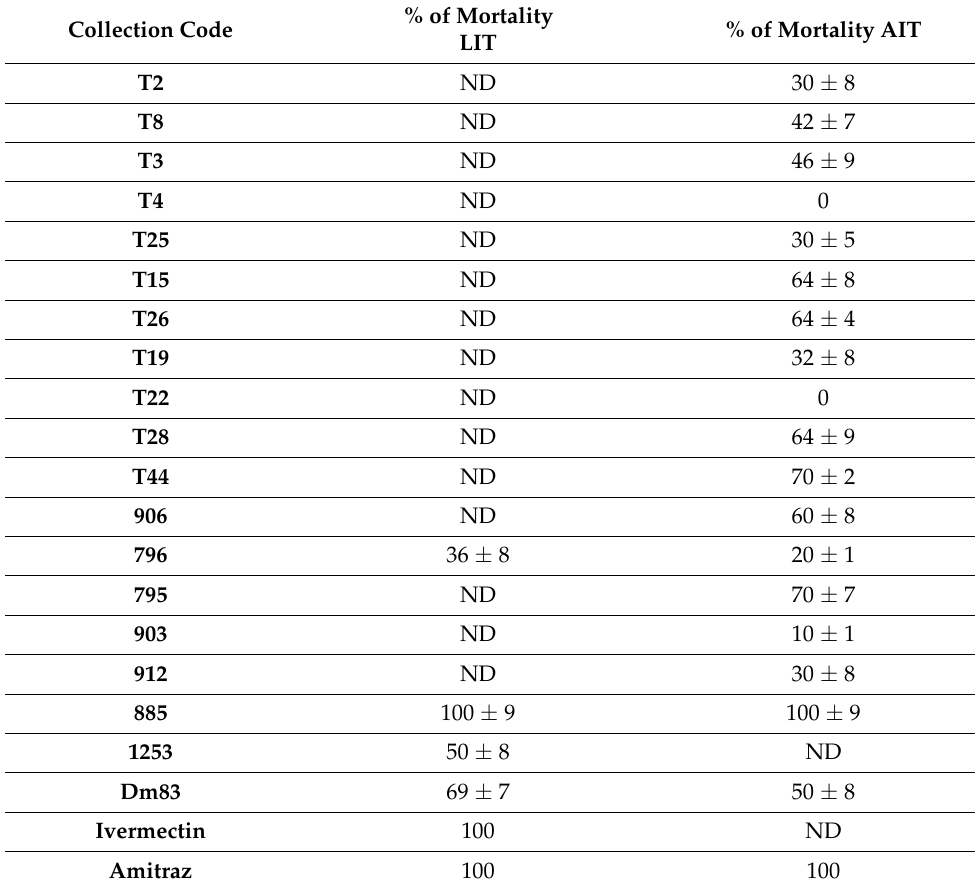
Table 4. Toxicity effect of extracts (1 mg/mL) and compounds in the LIT (1.0 mM) and the AIT (1.5 mM).